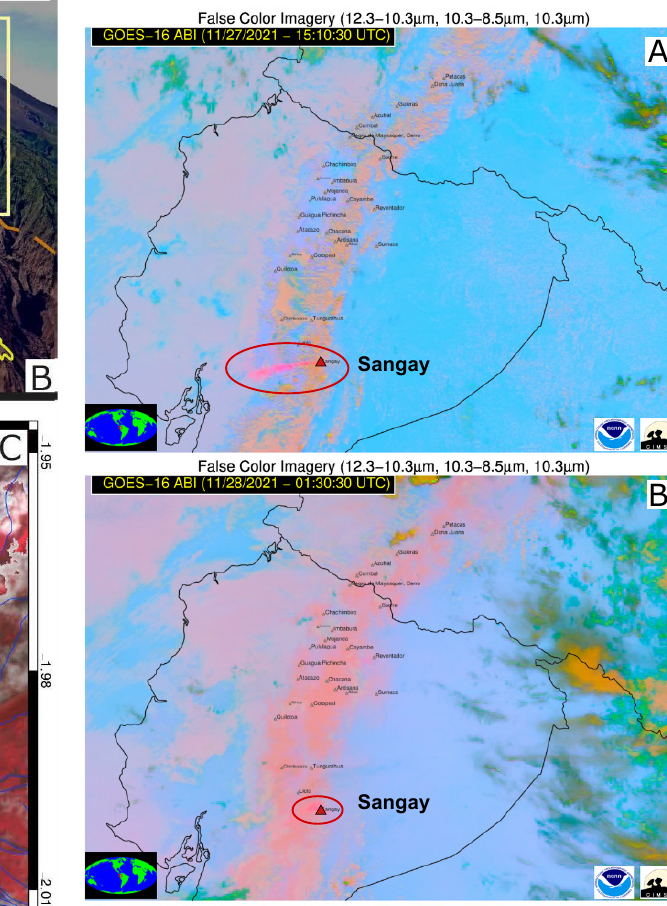
Figure 8: Volcanic clouds from Sangay volcano (bright pink color) on 27 November [A] and 28 November [B] by using the False Color Imagery (Source: